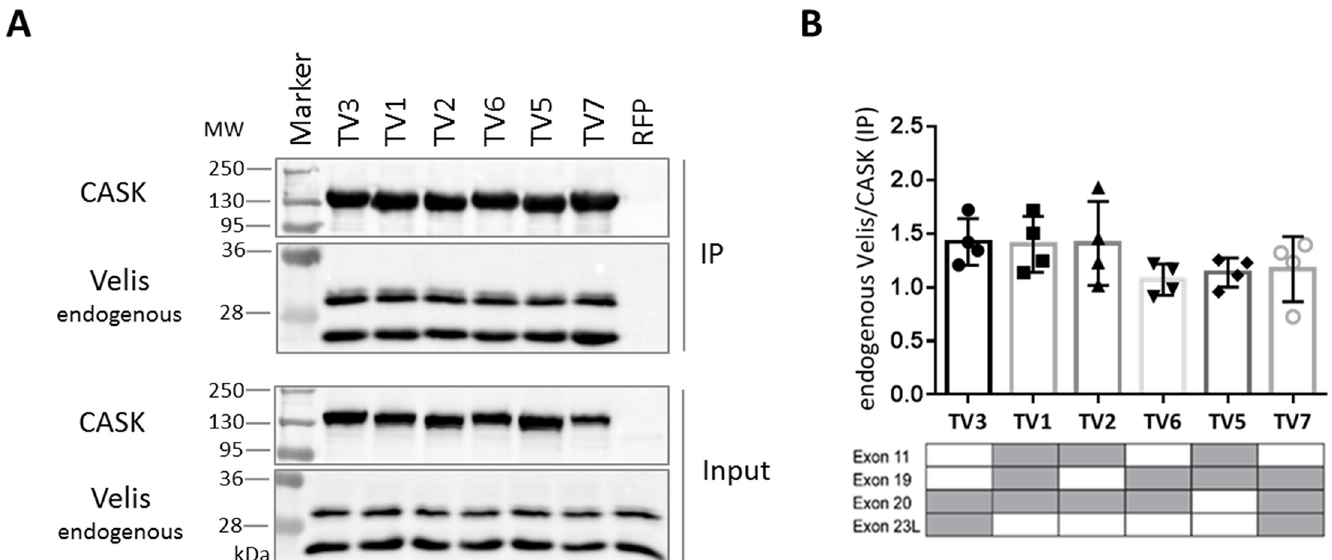
Fig 7. All CASK variants bind equally well to Veli proteins. A: HEK293-T cells expressing mRFP-tagged CASK variants or mRFP alone were lysed using RIPA buffer. RFP-tagged proteins were immunoprecipitated by the RFP-Trap matrix; input and precipitate samples were analysed by western blot using α -CASK and α -Veli antibodies. B: The ratio of Veli/CASK signal in precipitates was used as a measure of strength of the interaction. Shown are the means ± SD of four independent experiments. The presence of alternatively spliced exons is indicated by grey colour in tables below the respective bar graphs.